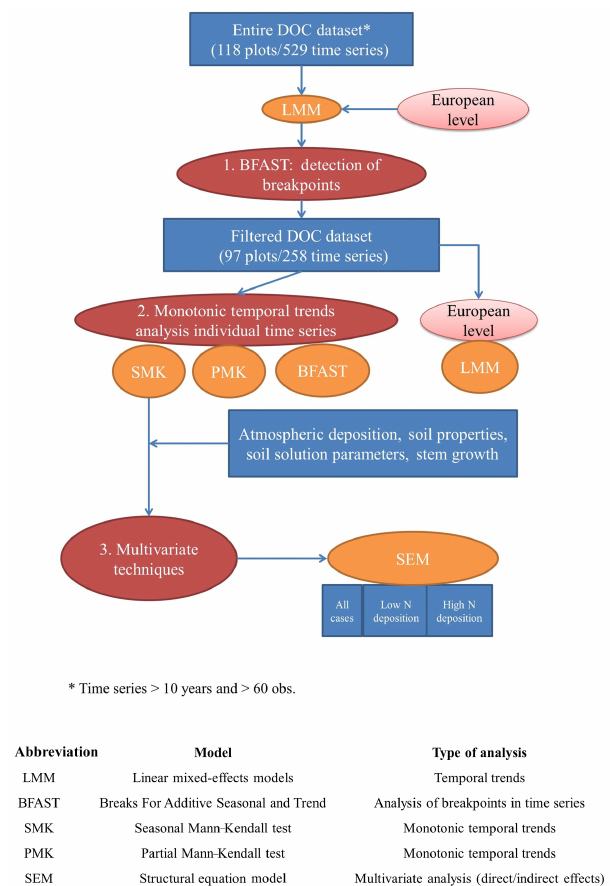
Figure 2. Flow-diagram of the sequence of methods applied for analysis of temporal trends of soil solution DOC and their